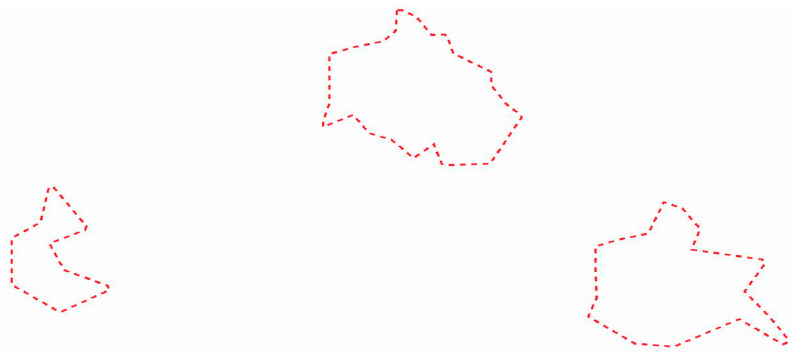
Figure 3. Borders of NZBM . Source: Author